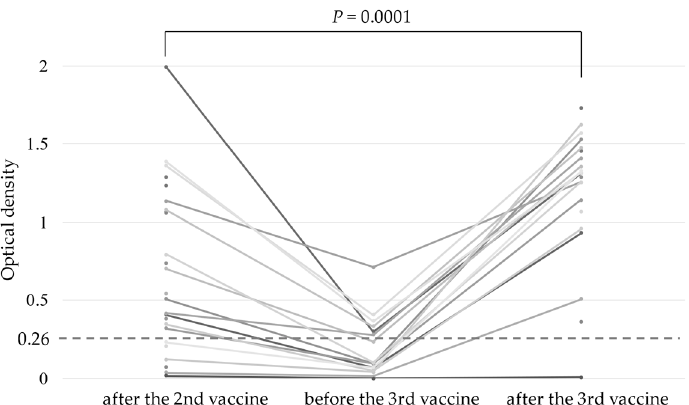
Figure 1. Anti-S1 antibody titers after vaccination. Anti-S1 antibody response after the second dose, prior to the third dose and 1–4 week(s) after the third dose in patients undergoing hematopoietic stem cell transplantation. The broken line indicates the cut-off value (0.26) for seroconversion.